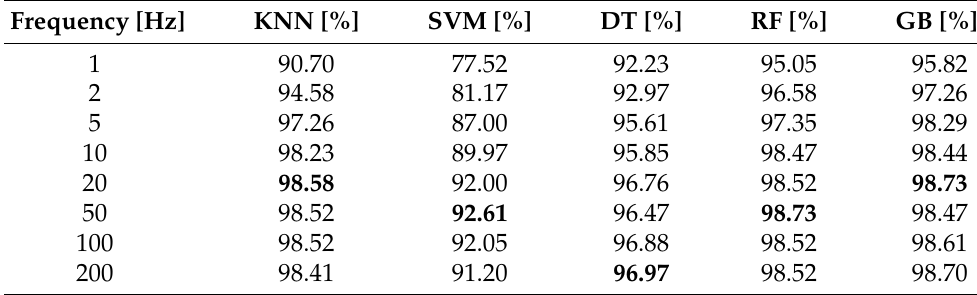
Table 7. Comparison of the accuracy across the ML algorithms, with the highest values in bold.